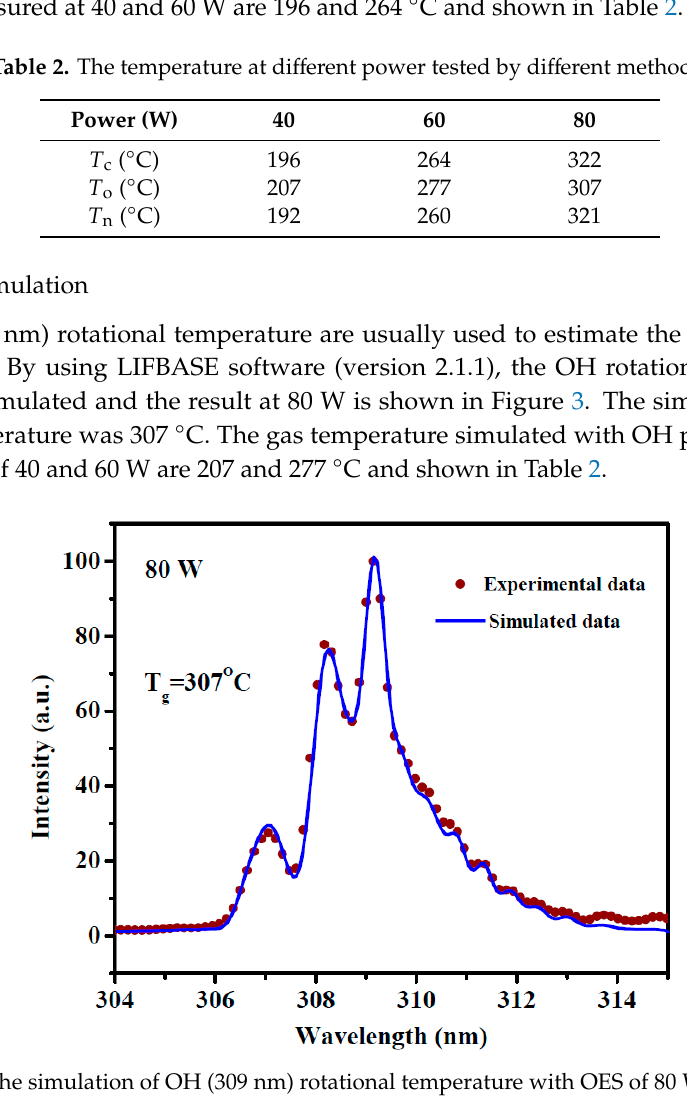
Figure 3. The simulation of OH (309 nm) rotational temperature with OES of 80 W